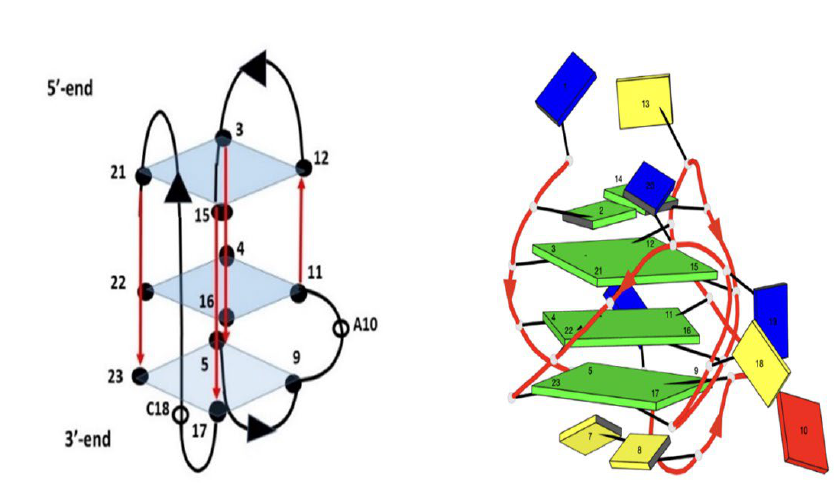
Figure 2. Schematic representation of TP3-T6 oligomer G-quadruplex. Adenine in red, Cytosine in yellow, Guanine in green and Thymine in blue.